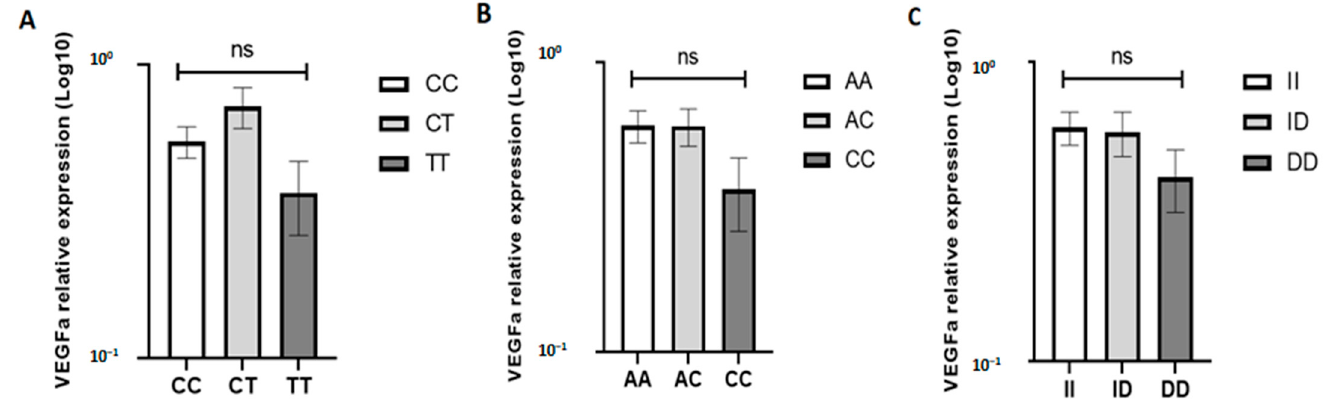
Figure 2. Association between the VEGFA mRNA expression level and the VEGFA SNP genotypes of − 460 C/T ( A ), − 2578 C/A ( B ), and − 2549 I/D ( C ). p -values ≥ 0.05 were labeled with ns (not significant).